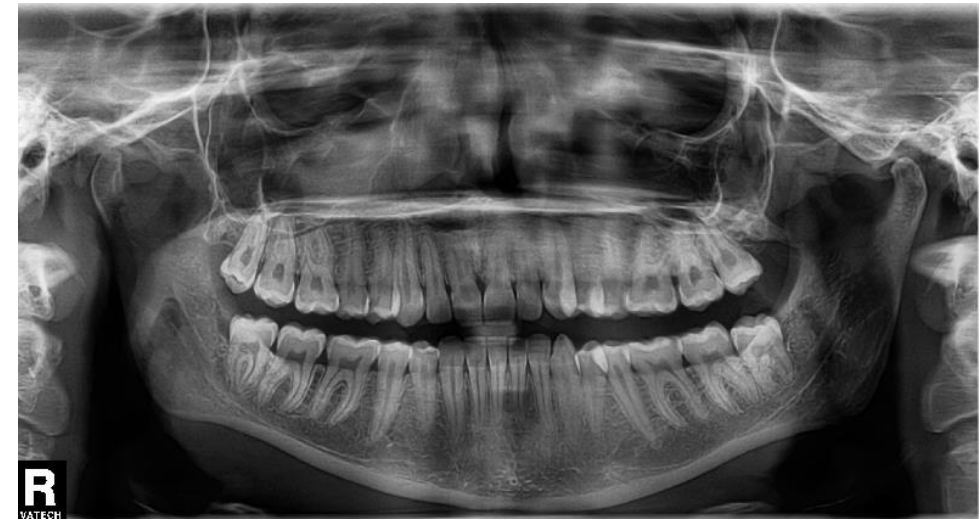
Figure 4. The orthopantomogram of the patient 3. Tooth No. 38 is in normal position, with a semilunar burnout distally.